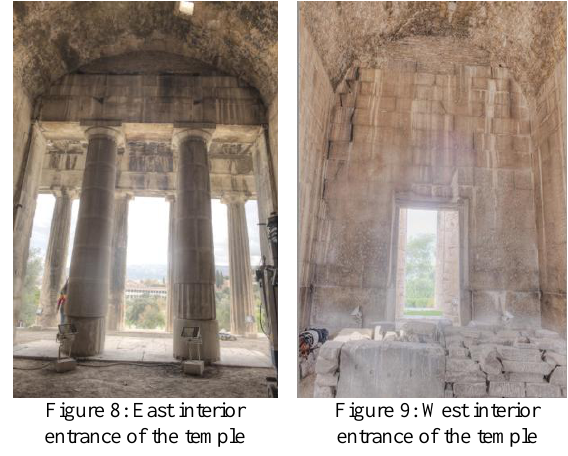
Figure 9: West interior entrance of the temple